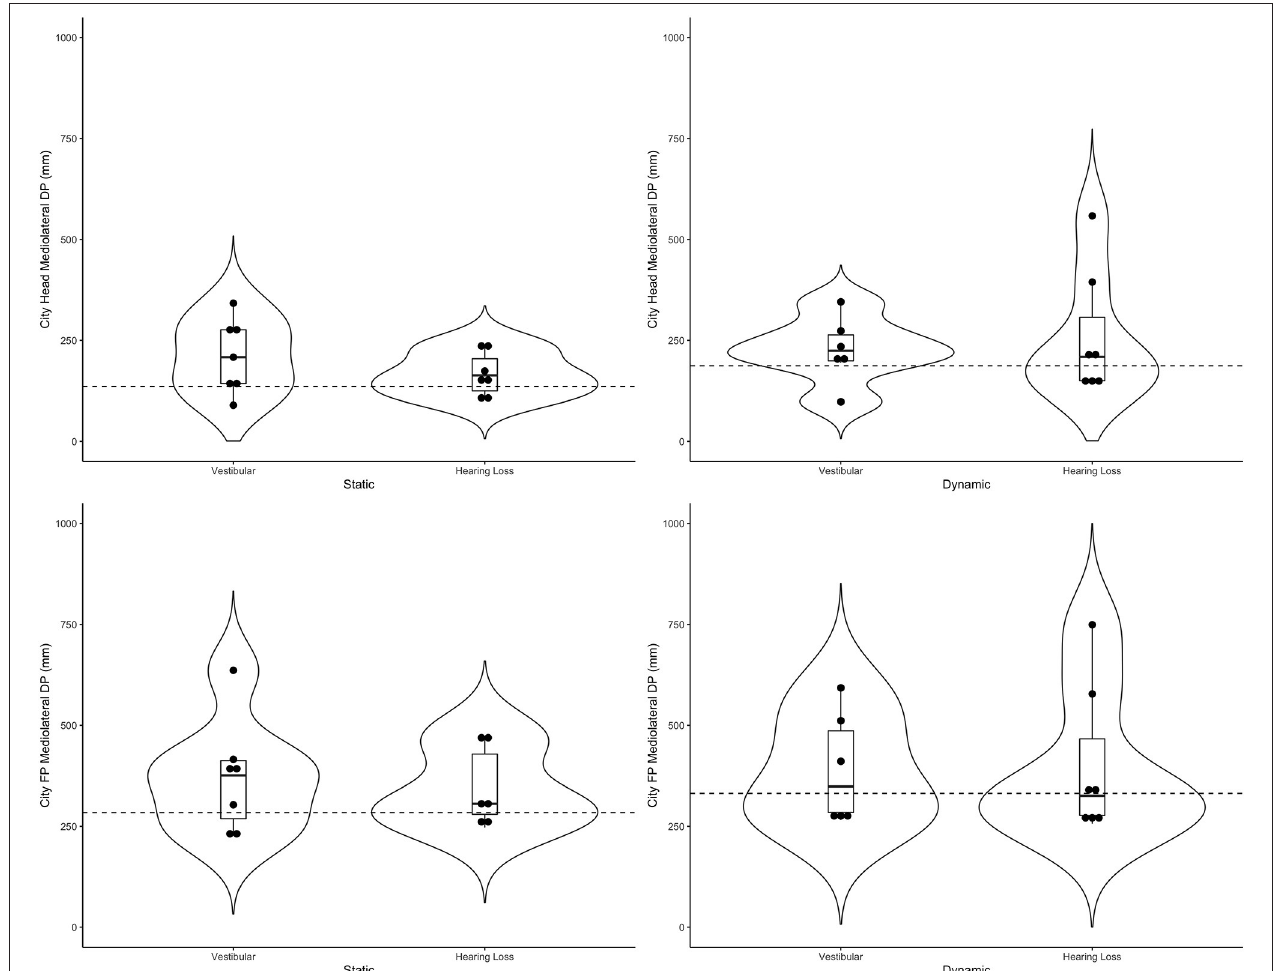
FIGURE 4 | Violin plots representing the distribution of both clinical groups around the mean of the control group (represented by the dashed line) for the city scene in the medio-lateral direction. Top plots show head data and bottom plots represent postural sway data (FP = forceplate). Left-hand side represents the static scenes and right-hand side represents the dynamic